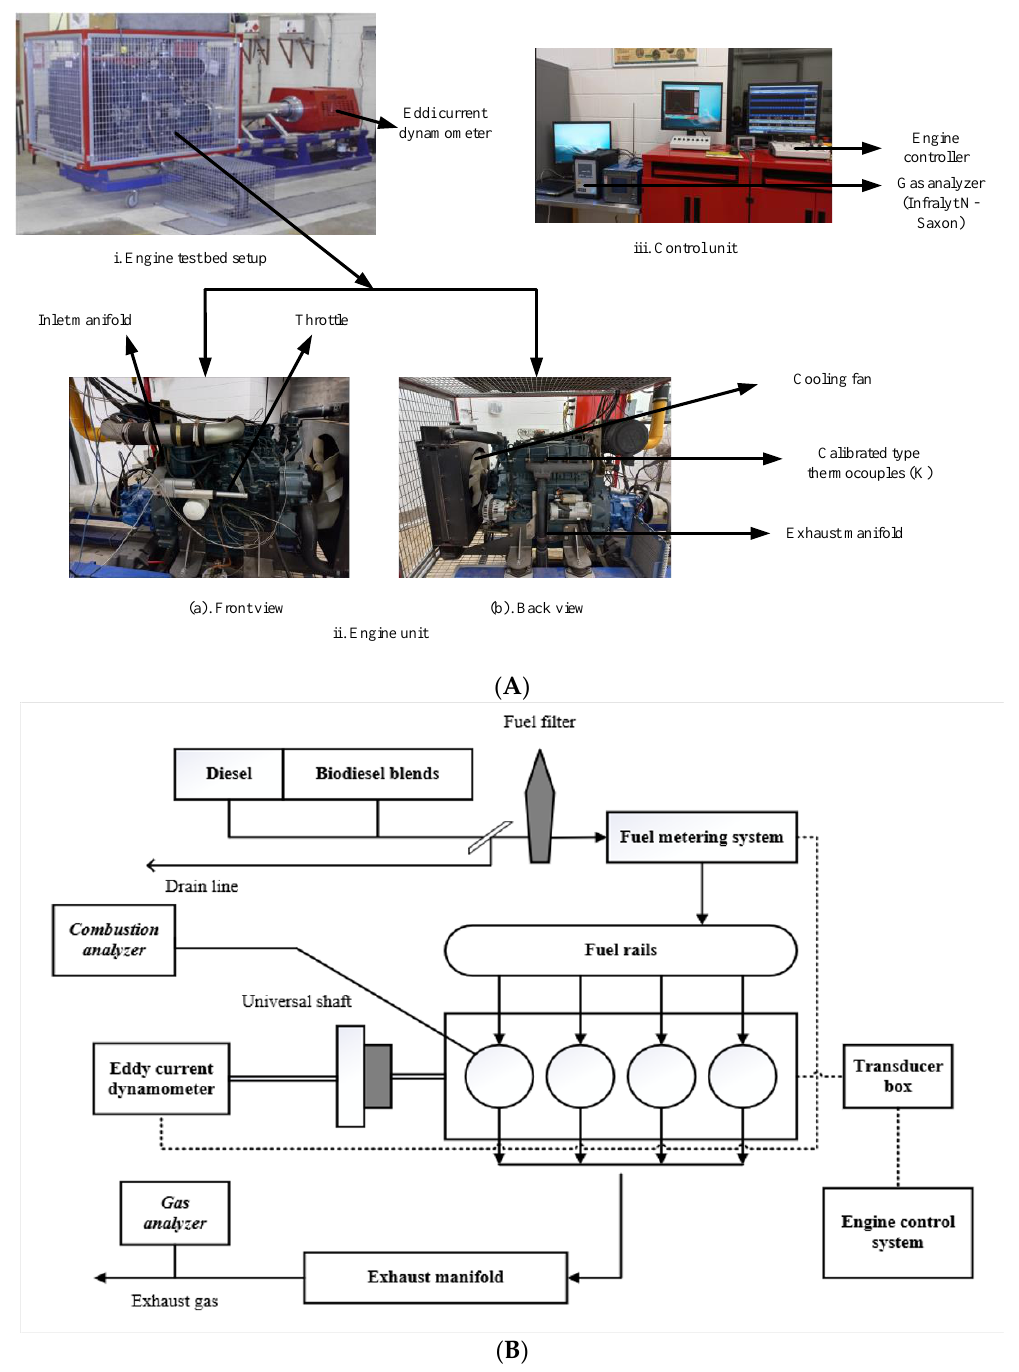
Figure 2. Engine test-bed setup with schematic layout. ( a ) Experiment setup. ( b ) Schematic layout.